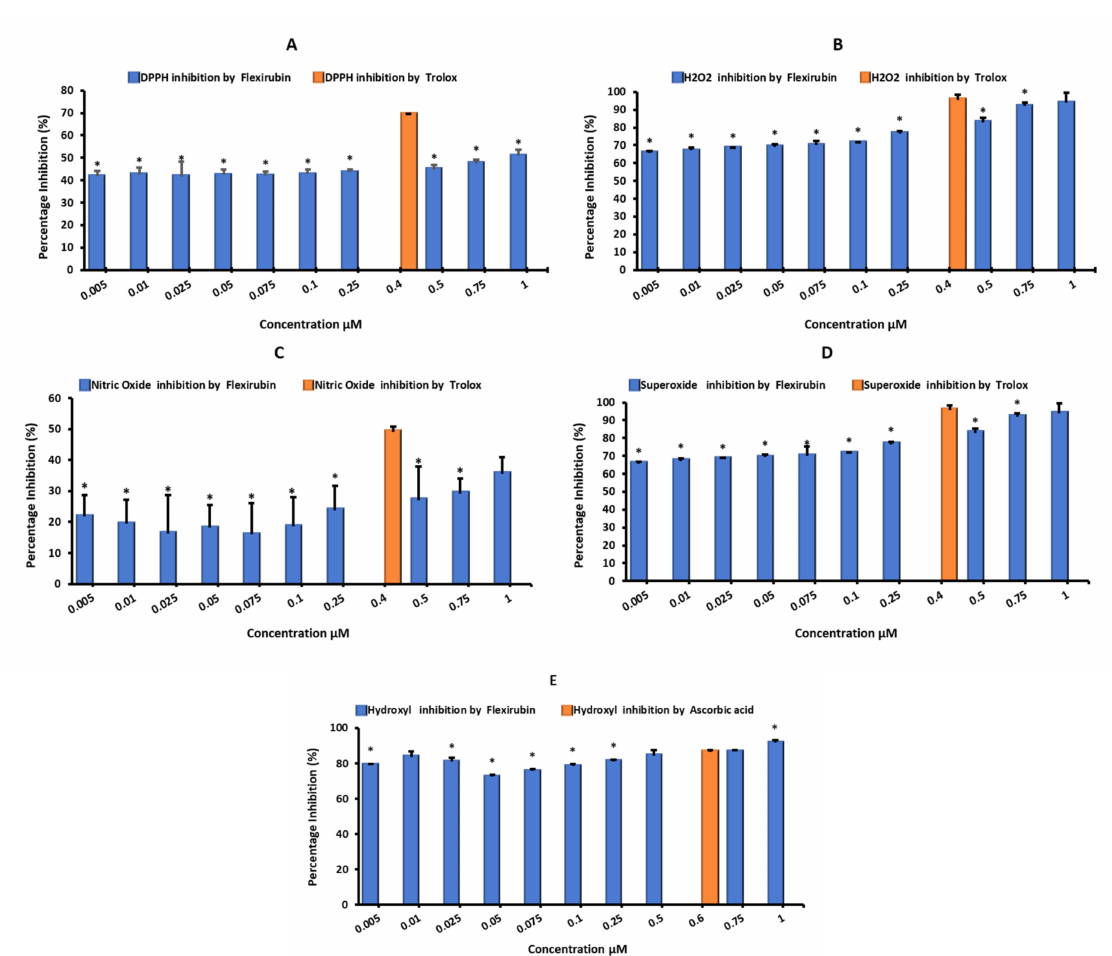
Figure 3. Antioxidant activity of flexirubin extract at different concentrations (0.005–1 µ M). ( A )2-2-Diphenyl-1-picryl- hydrazyl (DPPH) free radical scavenging activity. ( B ) Hydrogen (H 2 O 2 ) peroxide scavenging activity. ( C ) Nitric oxide (NO) radical-scavenging ability. ( D ) Superoxide (O 2 − ) radical scavenging ability. ( E ) Hydroxyl (OH − ) radical scavenging activity. Each point represents the mean ± SD ( n = 3); * shows statistically significant differences at p ≤ 0.05 in the observed activities when compared with that of Trolox or ascorbic acid